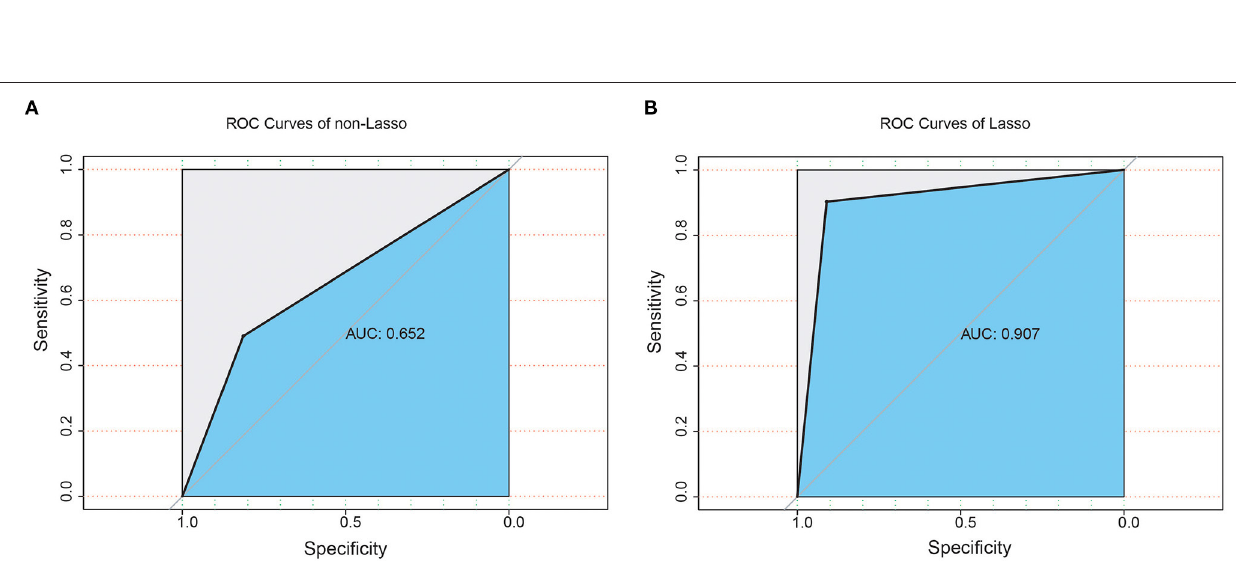
Frontiers in Public Health |